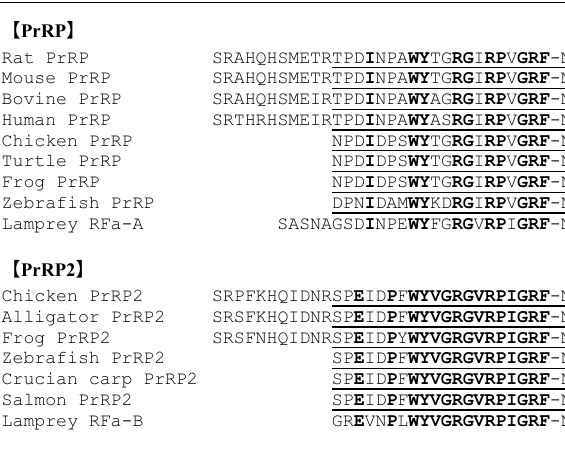
human PrRP genes are located on chromosomes 9q36 and